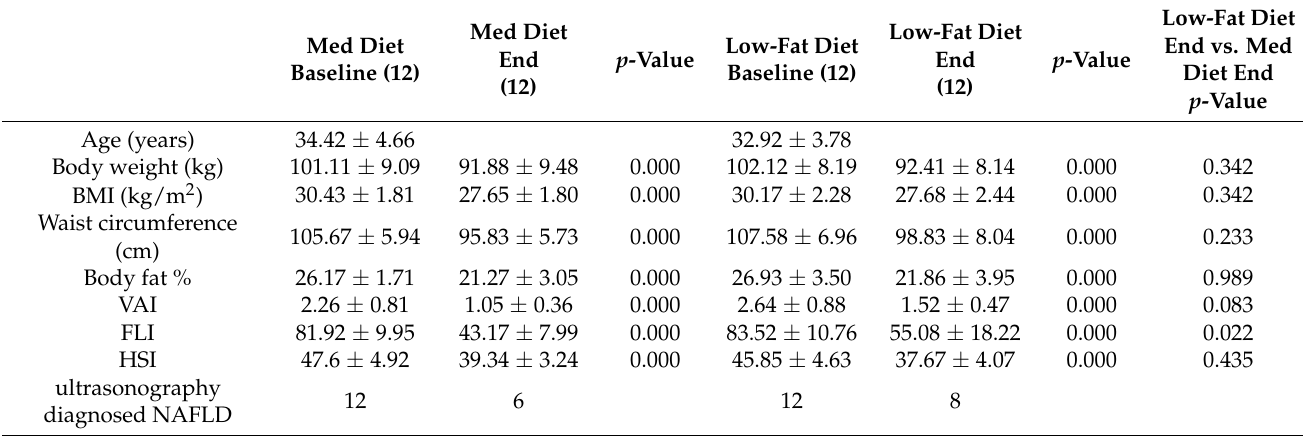
Table 1. Anthropometric and clinical data on nonalcoholic fatty liver disease (NAFLD) patients and the changes induced by dietary treatments.